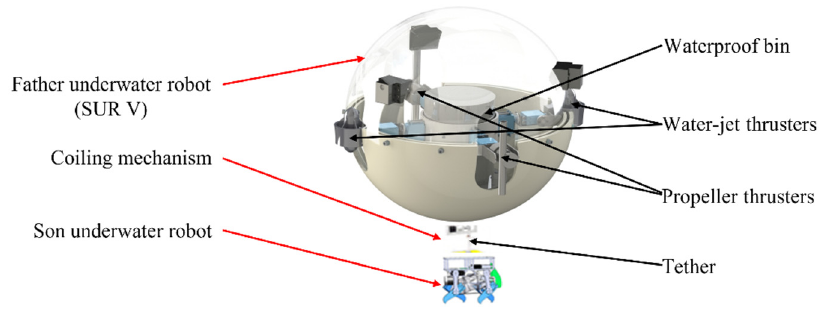
Figure 2. Three-dimensional model of the FURS system.